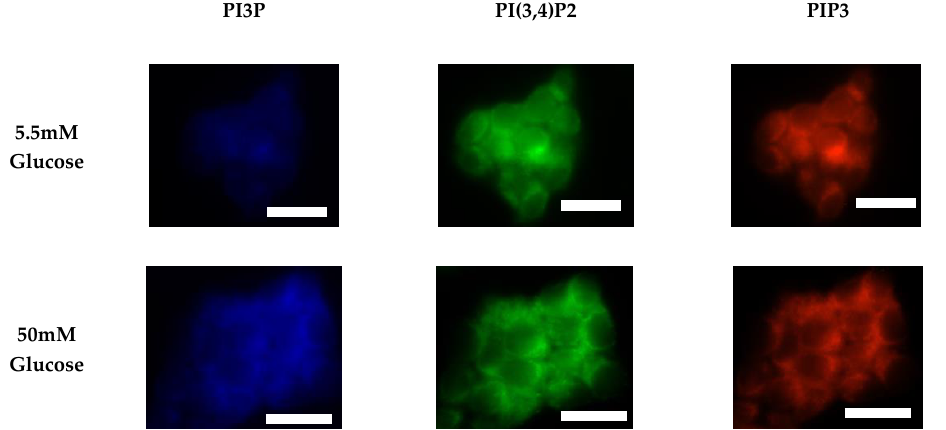
Figure 7. Glucose concentration changes cellular expression of PIPs in HER2+ cells. Representative fixed cell fluorescent images of SKBR3 cells cultured in normal (5.5 mM) and hyperglycemic (50 mM) serum glucose with immunofluorescent tags against PI3P, PI(3,4)P2, and PIP3. Scale bars represent 30 μm.